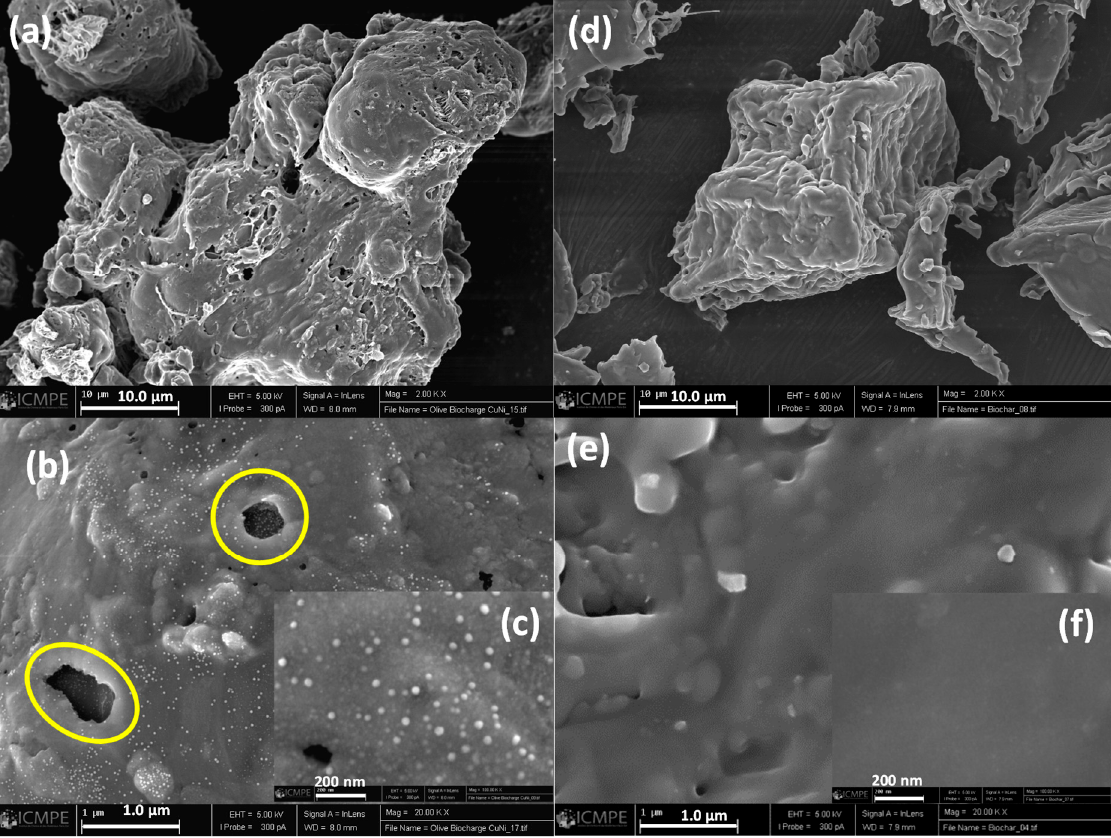
Figure 2. SEM images of biochar/CuNi hybrid ( a – c ) and the reference pristine biochar ( d – f ) without any supported nanocatalysts, at indicated magnifications. Some pores (in ( b )) enriched with CuNi nanoparticles are surrounded by a circle and an ellipse.